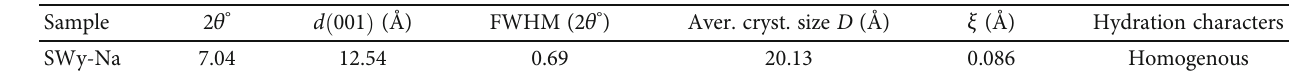
Figure 2: Best agreement obtained between theoretical and experimental pro fi les in the case of the SWy-Na complex. Table 3: Qualitative XRD investigation in the case of the SWy-Na